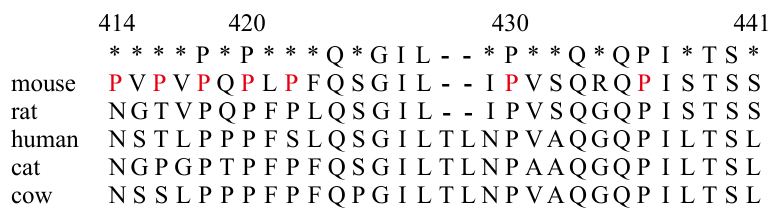
Figure 6. Comparison of the 414–441 region with the corresponding sites of IL-7Rα in various species. The 414-441 region contains proline residues (in red). These amino acids may provide docking site for the SH3 domain.